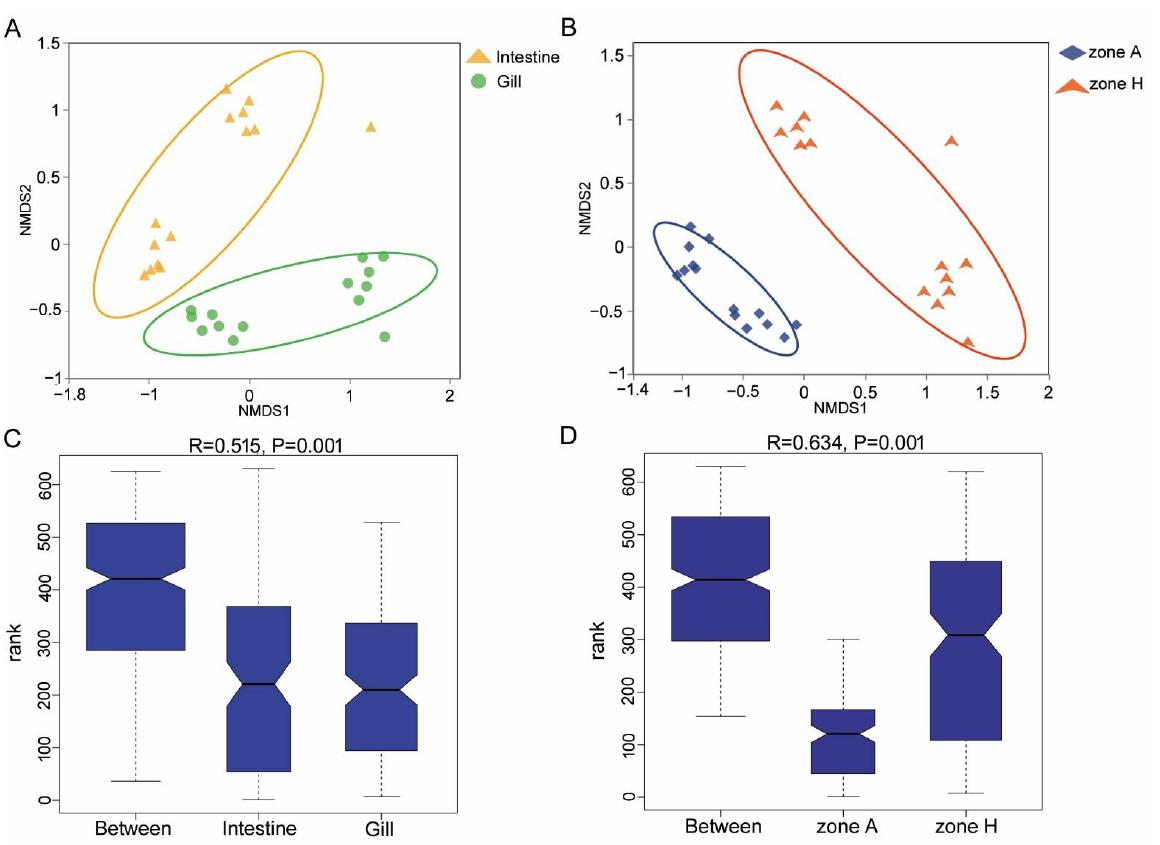
Figure 3. The beta diversity analysis of microbiota at the OUT level. ( A , B ) The NMDS analysis; ( C , D ) Anosim analysis. All analyses were based on the Bray-Curtis distance algorithm.